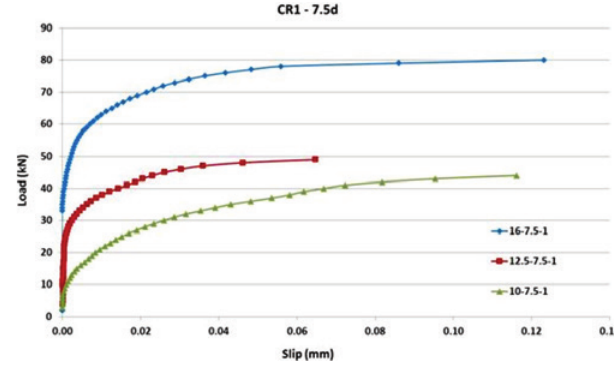
Influence of the embedded length, models: 12.5-5-0 and 12.5-7.5-0